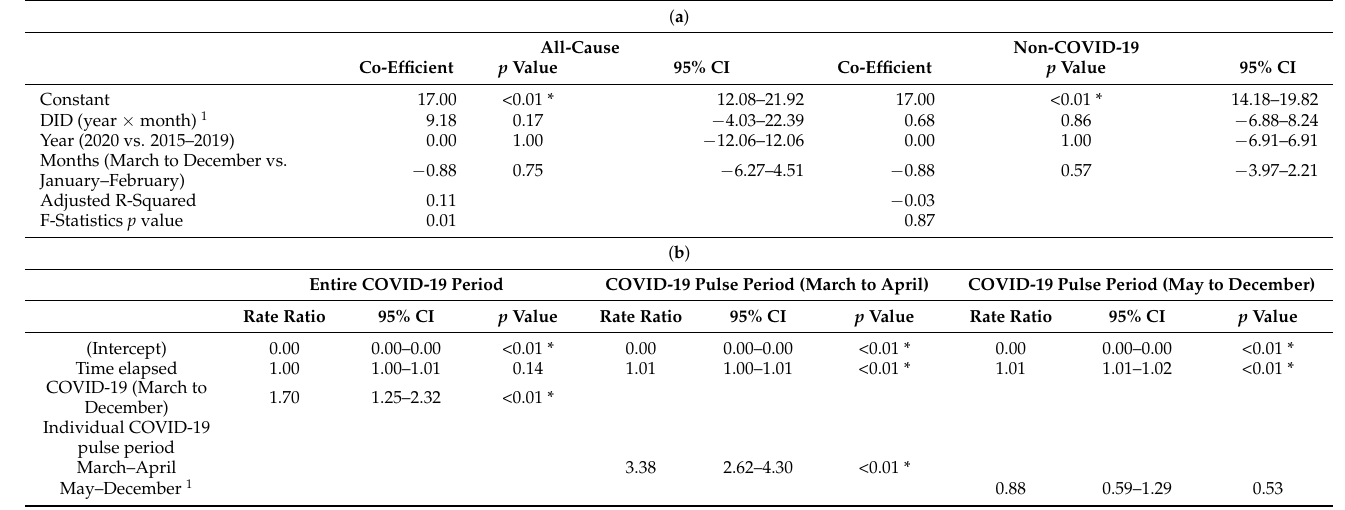
Table 1. ( a ). Difference-in-difference analysis in monthly number of all-cause (including COVID-19) and non-COVID-19-associated deaths. ( b ). Comparison of time series analysis with step change for the entire COVID-19 period and pulse periods in 2020.